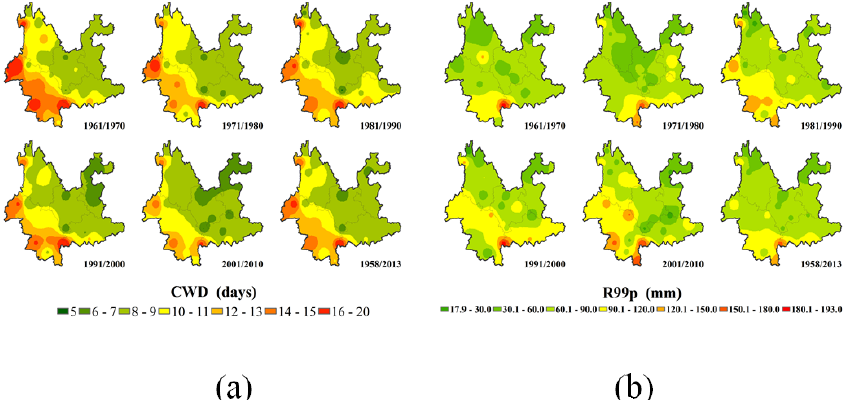
Figure 4. Spatial distribution of decadal mean extreme precipitation indices in Yunnan Province during the period of 1958–2013 (a) CWD and (b) R99p.